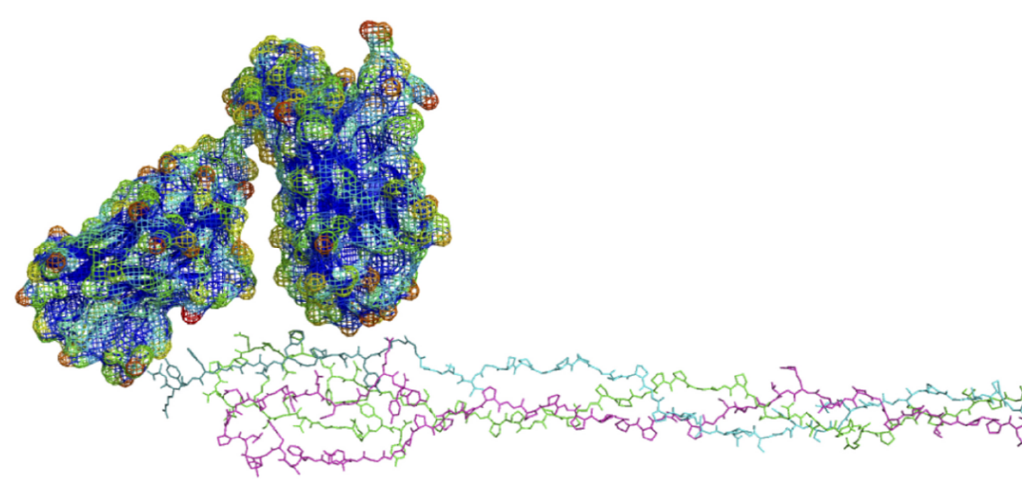
Figure 8. Preliminary molecular simulation of docking between the scFv antibody and the α 2Ct epitope of rat collagen. Lower figure: C-terminus of the rat type I collagen model; α 1(I) chains, purple and green; α 2(I) chain, cyan, α 2Ct epitope, dark cyan. Upper figure: scFv antibody with highly water accessible “exposed” regions (mesh surface) color-scaled towards the red end of the spectrum; green is intermediate and blue is not exposed. Antibody subunits show potentially complementary binding interactions at α 2Ct epitope (see text).